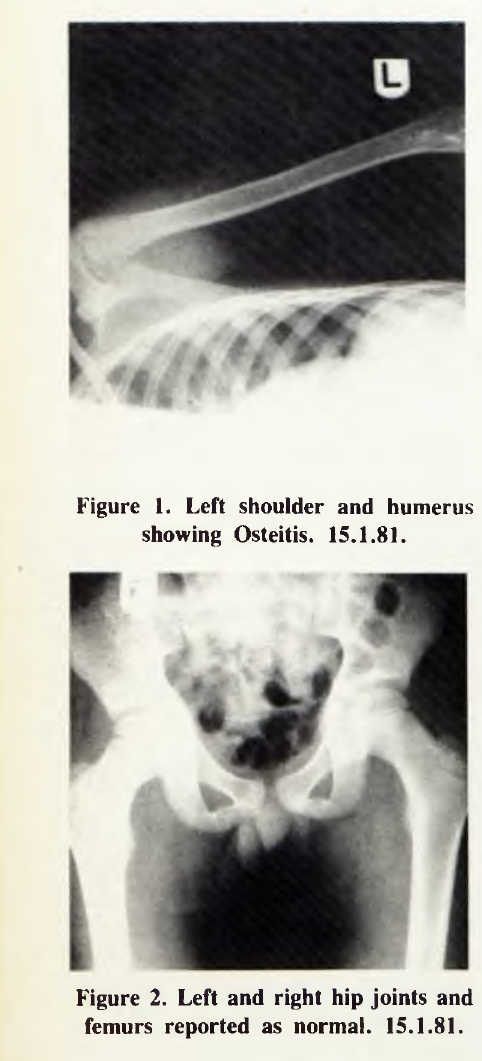
Figure 2. Left and right hip joints and femurs reported as normal. 15.1.81.